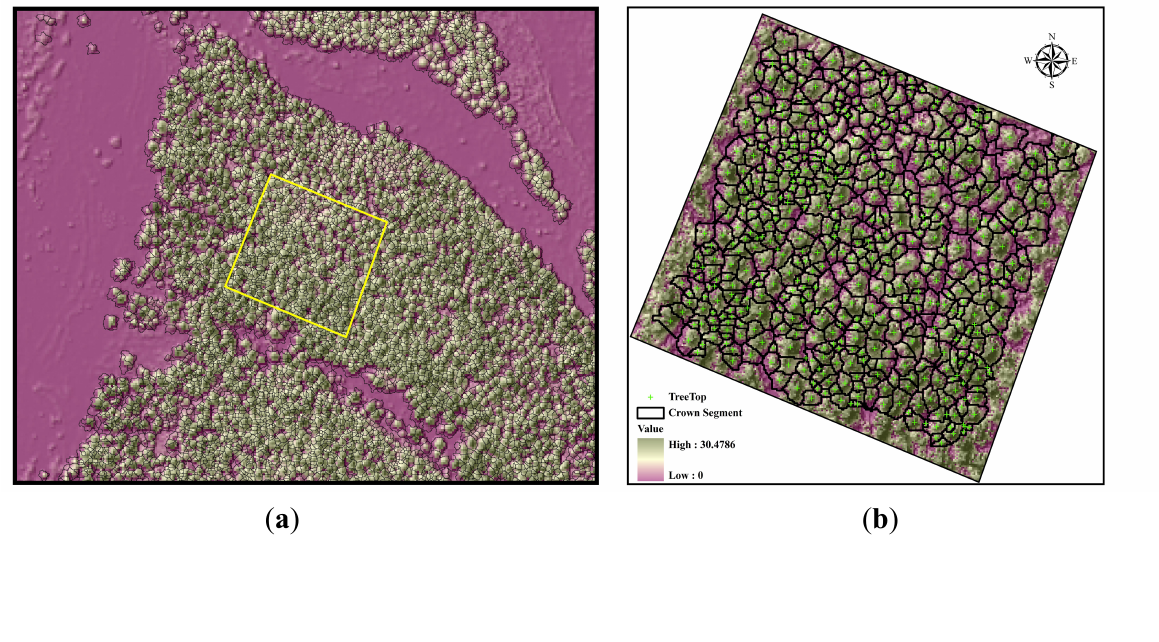
Figure 4. Canopy height model overlaid with tree crown segments derived from watershed segmentation: ( a ) near the super-plot (within yellow boundary); ( b ) within the super-plot together with measured tree